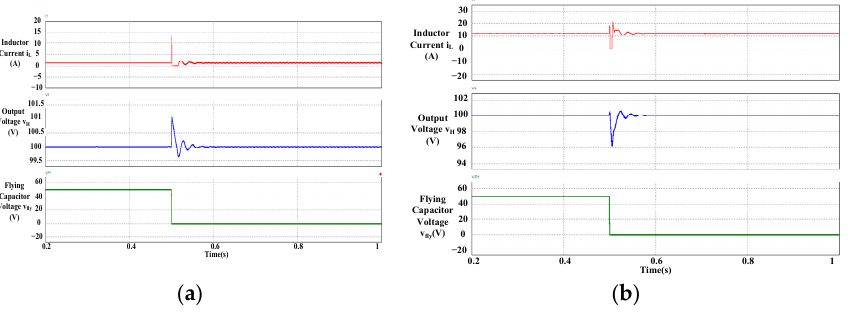
Figure 17. The waveforms of S 3 short-circuit fault (V L < 0.5 V H ). ( a ) Light load 100 W; ( b ) heavy load 1000 W.